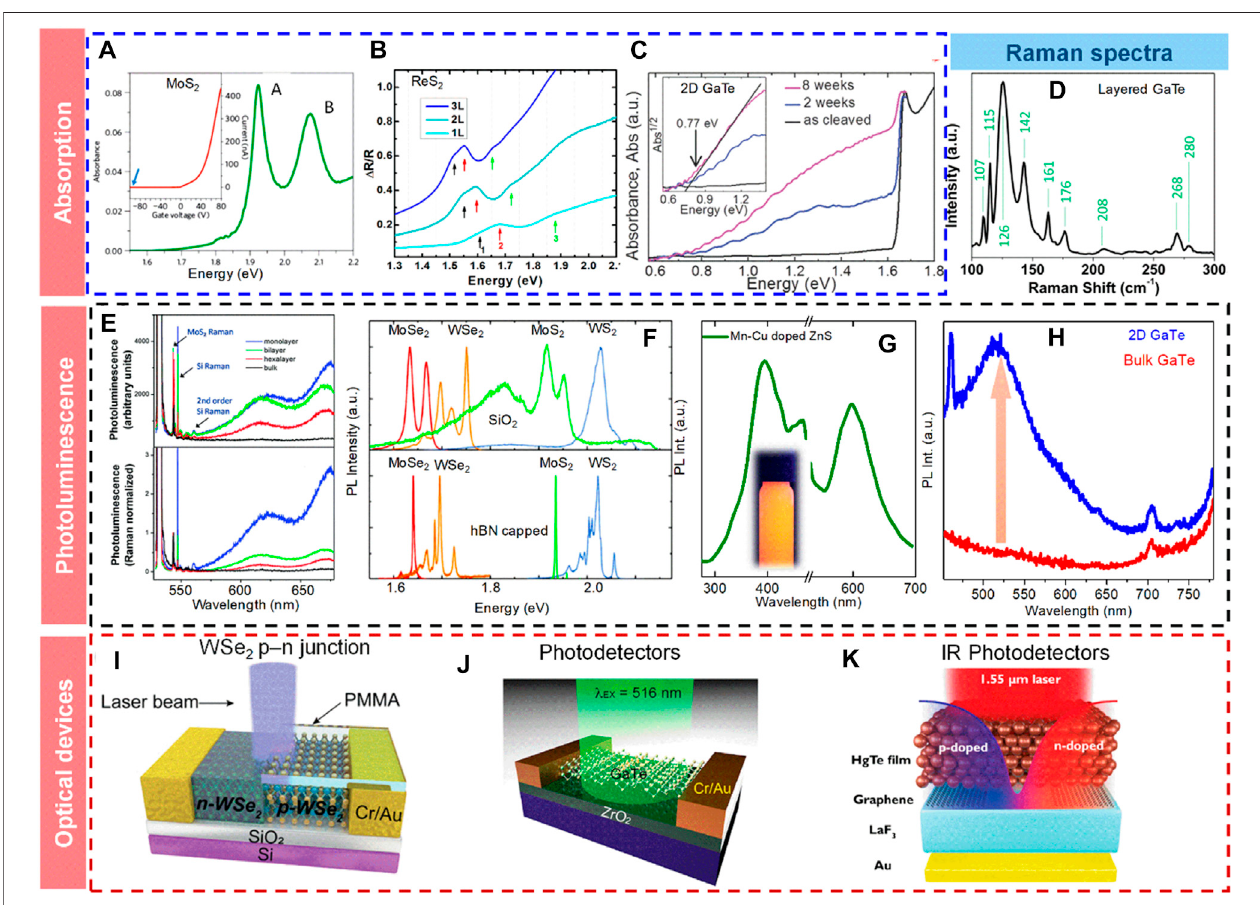
FIGURE 3 | (A) Absorption spectra of monolayer MoS 2 [adapted and modi fi ed from (Vikraman et al., 2017)]. (B) Layer-dependent re fl ectance spectra of ReS 2 [adapted and modi fi ed from (Zhao K. et al., 2018)]. (C) Absorption spectra of layered GaTe with and without oxidation. Inset shows the change in bandgap due to oxidation [adapted and modi fi ed from Fonseca et al.,2016]. (D) Raman spectra of GaTe [adapted and modi fi ed from (Huang et al., 2016)]. (E) PL emission spectra of monolayer MoS 2 with Raman signal [adapted and modi fi ed from (Eda et al., 2011)]. (F) PL emission spectra of MoS 2 , WS 2 , MoSe 2 , and WSe 2 in the different substrates [adapted and modi fi ed from (Cadiz F. et al., 2017)]. (G) Yellow-orange emission of layered ZnS. Inset shows the digital photograph of the sample signal [adapted and modi fi ed from (Kumbhakar et al., 2019)]. (H) Comparison PL emission spectrum of bulk and 2D GaTe [adapted and modi fi ed from (Siddique et al., 2021)]. Schematic diagram of (I)